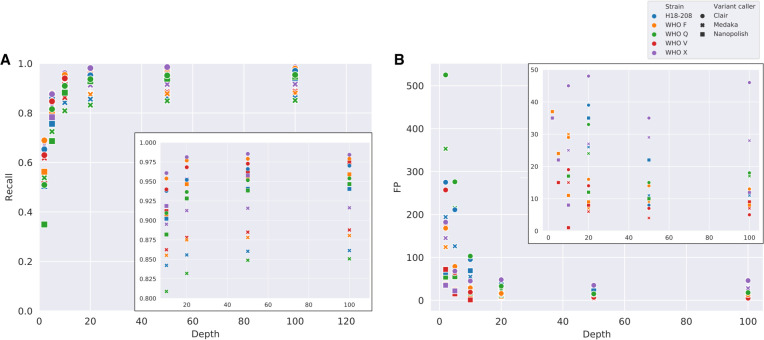
Effect of read coverage depth on SNP calling for each strain and variant caller. (A) SNP recall by median depth of coverage. (B) False positive SNPs (FP) by median depth of coverage. Color represents different sequences, shapes represent variant callers, circles are Clair, crosses are Medaka, and squares are Nanopolish. Insets show upper and lower regions of the y-axis in more detail for A and B, respectively.